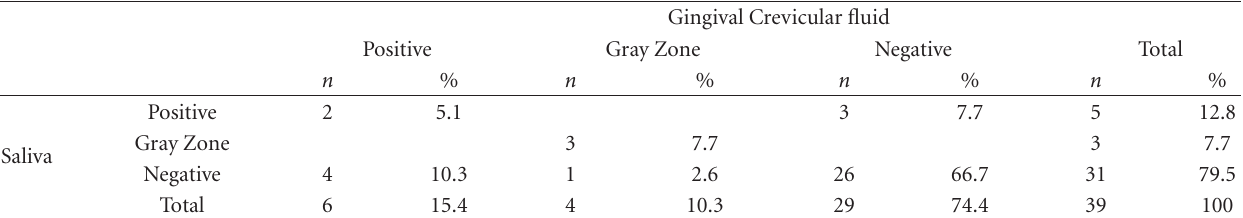
Table 1: Crosstabulation of HCV antibodies Immunoreactivity in Gingival Crevicular fluid and Saliva, Kappa = 0.426; p < .001.